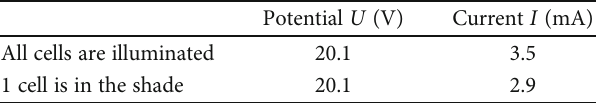
Table 3: Results of the current and